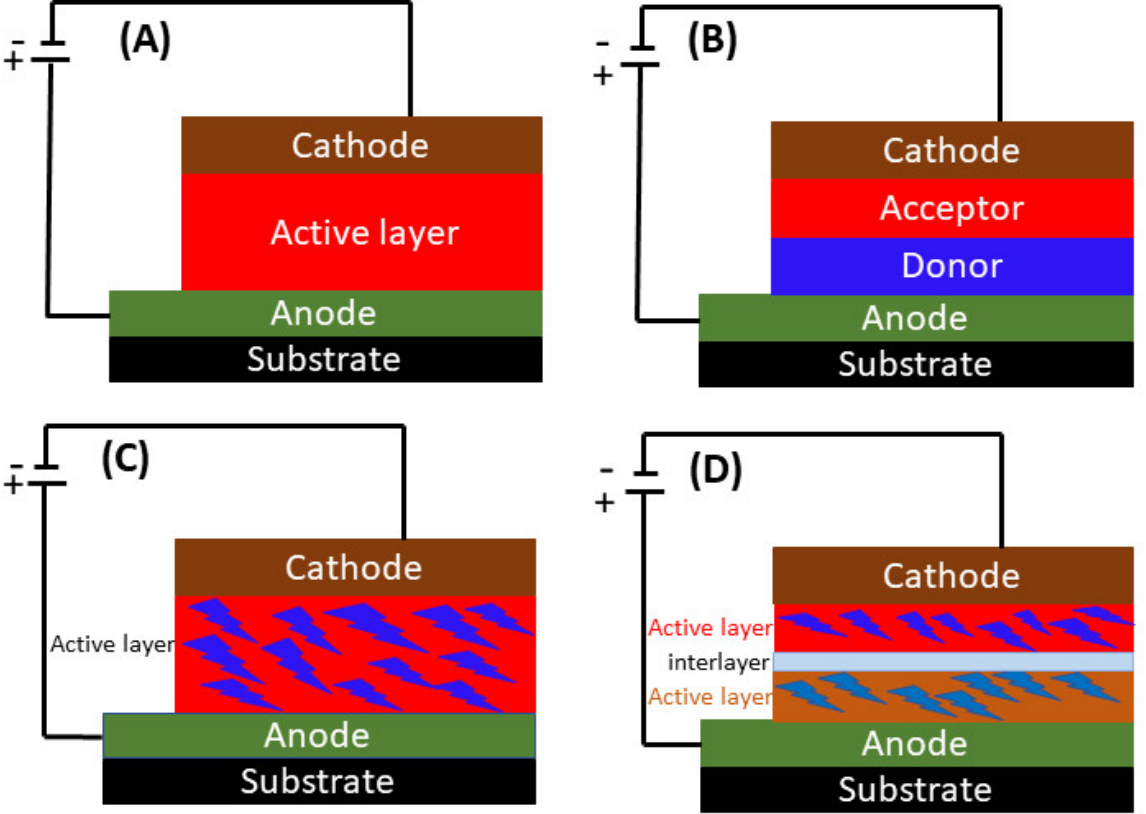
Figure 2. The fabrication of OSC: ( A ) single active layer, ( B ) bilayer heterojunction, ( C ) bulk hetero- junction, ( D ) tandem heterojunction.